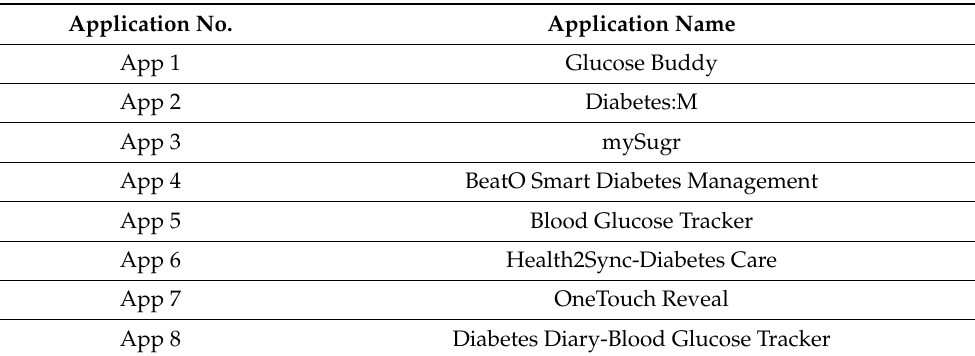
Table 1. T2DM mHealth apps reviewed in this study. Application